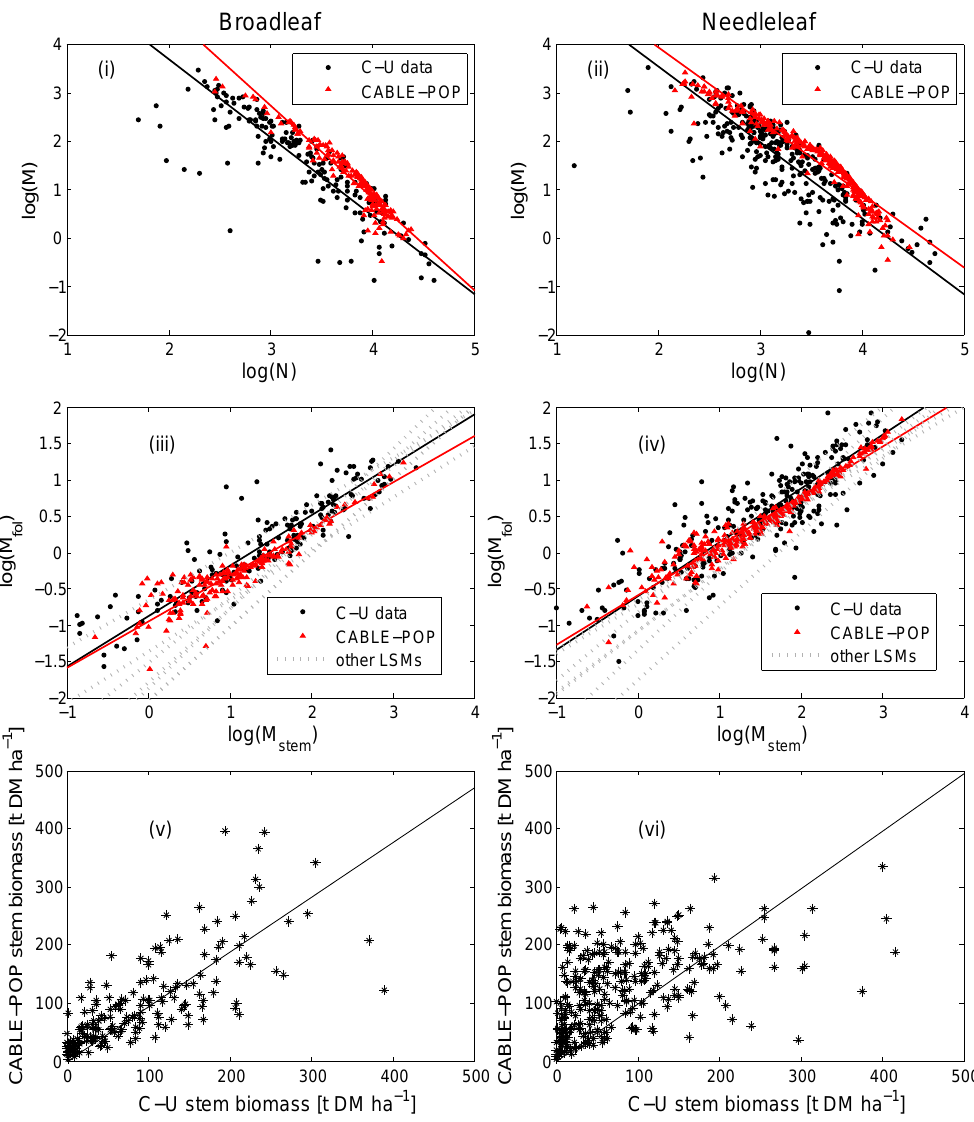
Figure 4. Evaluation of CABLE-POP predictions against Cannell–Usoltsev data, separated into broadleaf and needleleaf classes respectively: (i) and (ii) biomass–density plot; (iii) and (iv) leaf–stem allometry plot (M fol and M stem are average foliage and stem biomass per tree (kg DM tree − 1 )) , including results derived for other LSMs by Wolf et al. (2011); and (v) and (vi) total biomass: predictions vs. observations. In (i–iv), lines denote linear fits to the observations and predictions. Solid lines denote linear regression fits to the data points (see Table 1 for regression